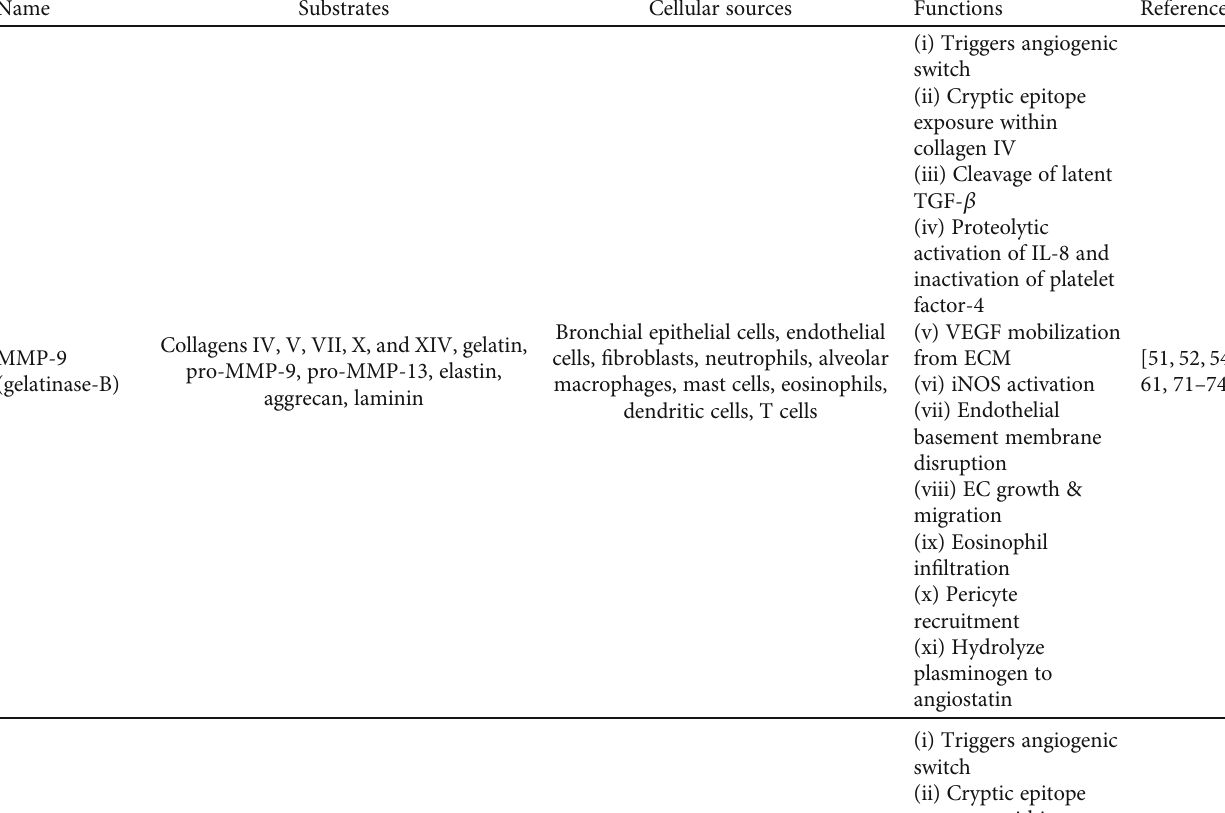
Table 1: MMPs implicated in promoting angiogenesis in